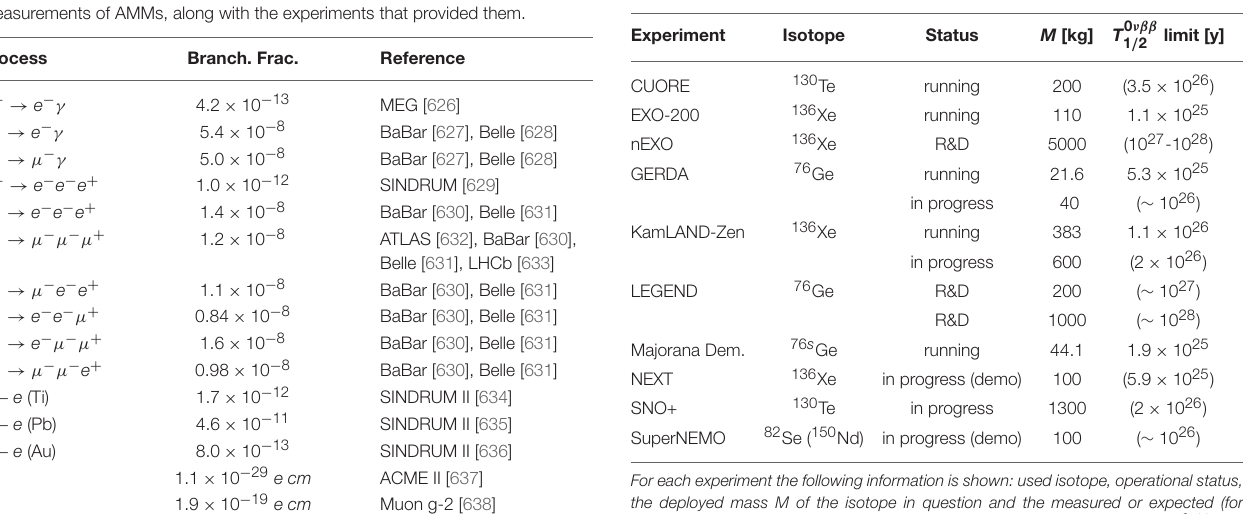
TABLE 3 | An overview of both current and future major 0 νββ decay